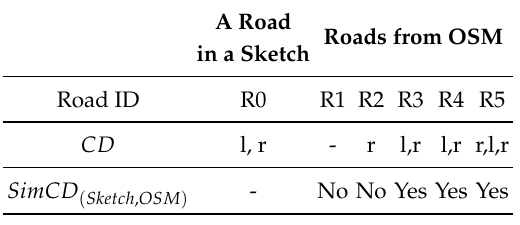
Table 3. CD of R0 and